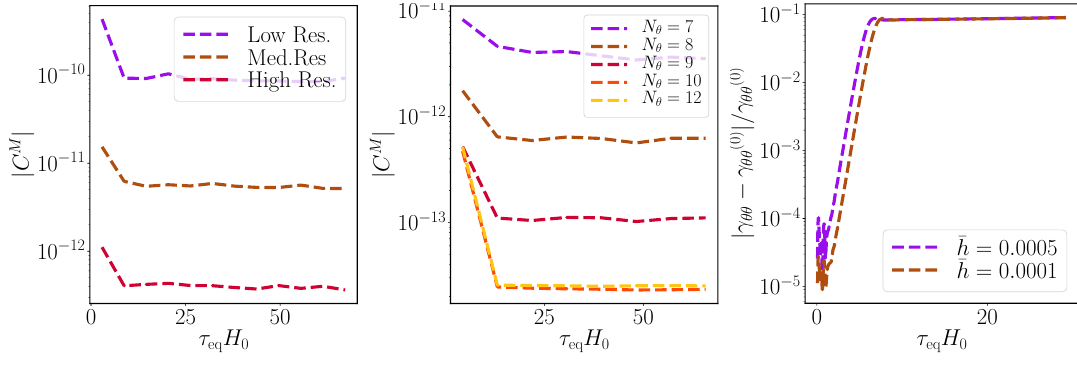
Figure 12 . Integrated norm of the constraint violation eq. (B.3) for different temporal (left) and spatial (middle) resolutions as a function of proper time (in units of the background Hubble expansion) for q = 4 , Λ = 1 , H/M = 0 . 0078 and an initial ‘ = 2 perturbation. The medium D 4 and high temporal resolutions have 2 × and 4 × the resolution of the low resolution run. N in θ the middle indicates the number of collocation points used. We find that the constraint violations converge at fourth order in time and exponentially in space. (Right) The time evolution of spatial average of relative difference of γ from its background solution for q = 4 , H/M = 0 . 0050 and an θθ 4 initial ‘ = 2 perturbation of magnitude ¯ h = 10 − 4 and ¯ h = 5 × 10 − 4 . The linear warped instability is